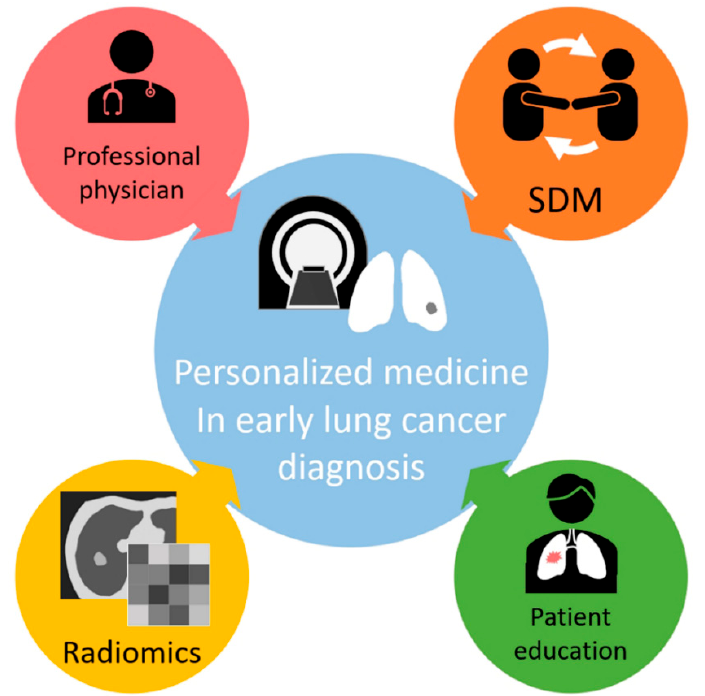
Figure 3. Four key elements required for the successful implementation of personalized medicine in early lung cancer diagnosis, including patient education, professional physician education, radiomic- based diagnostics, and SDM (shared decision